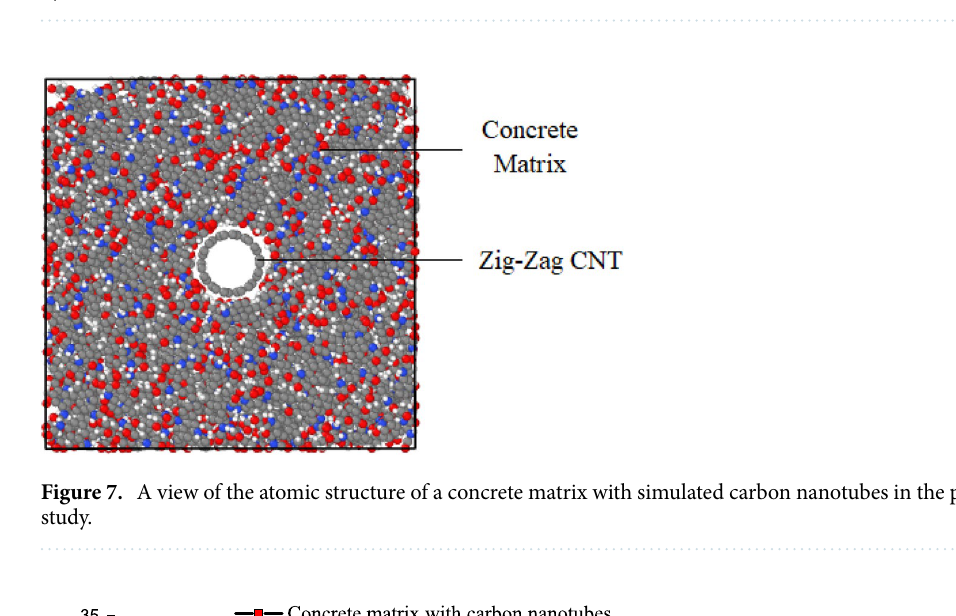
Figure 6. Calculated stress–strain and Young’s modulus diagrams for concrete structure using molecular dynamics method.